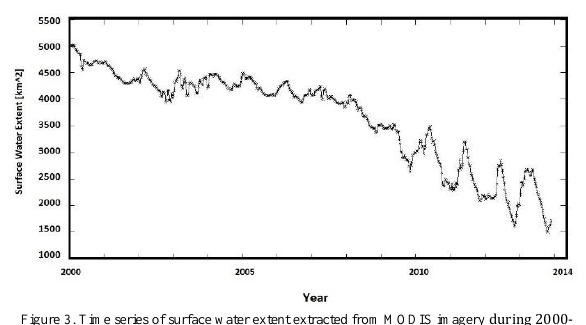
Figure 3. Time series of surface water extent extracted from MODIS imagery during 2000- 2014 years.